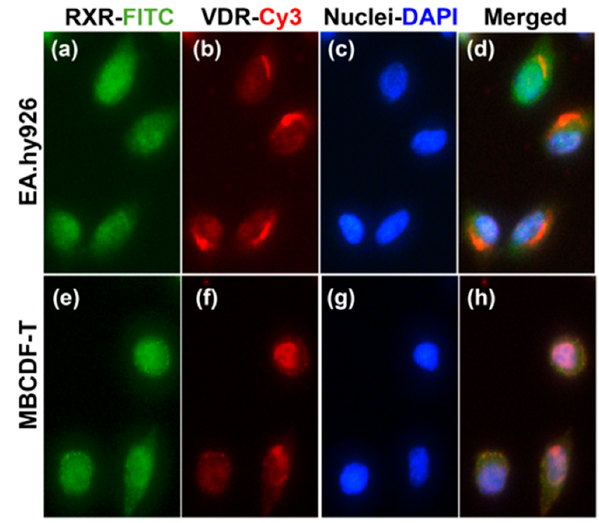
Figure 1. Vitamin D receptor (VDR) and retinoid X receptor (RXR) immunolocalization in EA.hy926 and MBCDF-T cells. EA.hy926 ( a – d ) or triple-negative breast cancer tumoral cells (MBCDF-T) ( e – h ) were seeded onto chamber slides. After fixing and permeabilizing, slides were co-incubated with rabbit anti-RXR and mouse anti-VDR antibodies. The secondary antibodies goat anti-rabbit-Fluorescein isothiocyanate (FITC) and goat anti-mouse-Cy3 allowed to identify RXR in green ( a , e ) and VDR in red ( b , f ). DAPI shows nuclei in blue ( c , g ). Merged photographs are shown in ( d , h ). Magnification: 40 ×